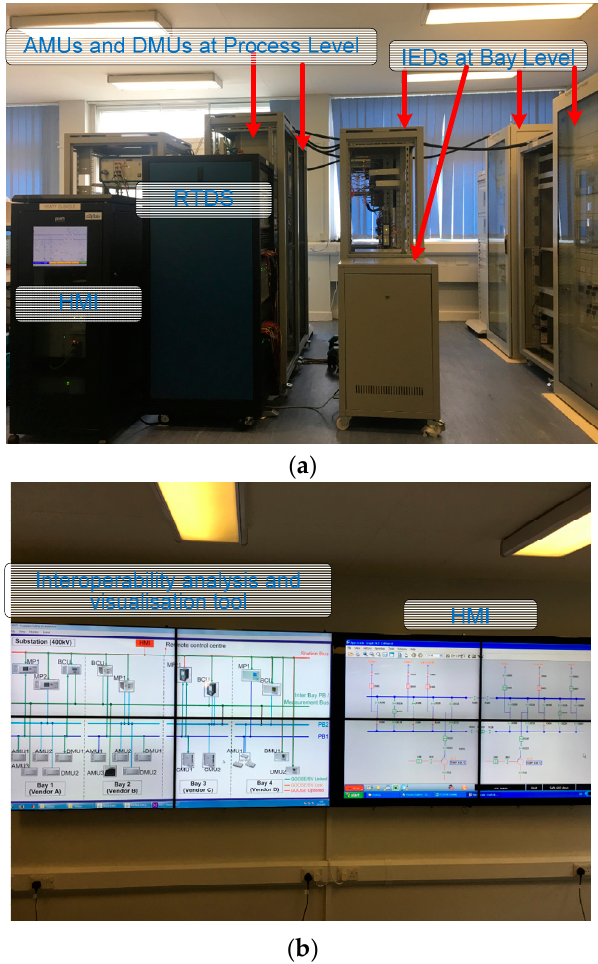
Figure 5. Lab layout of test system consists of ( a ) hardware platform and ( b ) HMI and interoperability analysis and visualisation tools.